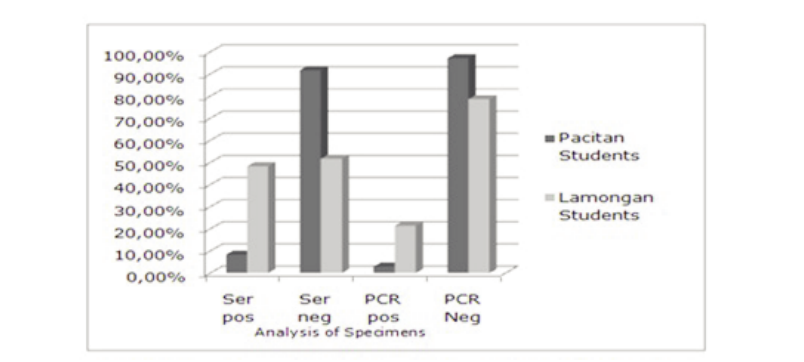
Figure 4. Distribution of seropositivity of IgM antibody and PGL-1 and PCR positivity in endemic leprosy area among healthy children in north coast (Lamongan District) and non-endemic leprosy area in south coast (Pacitan